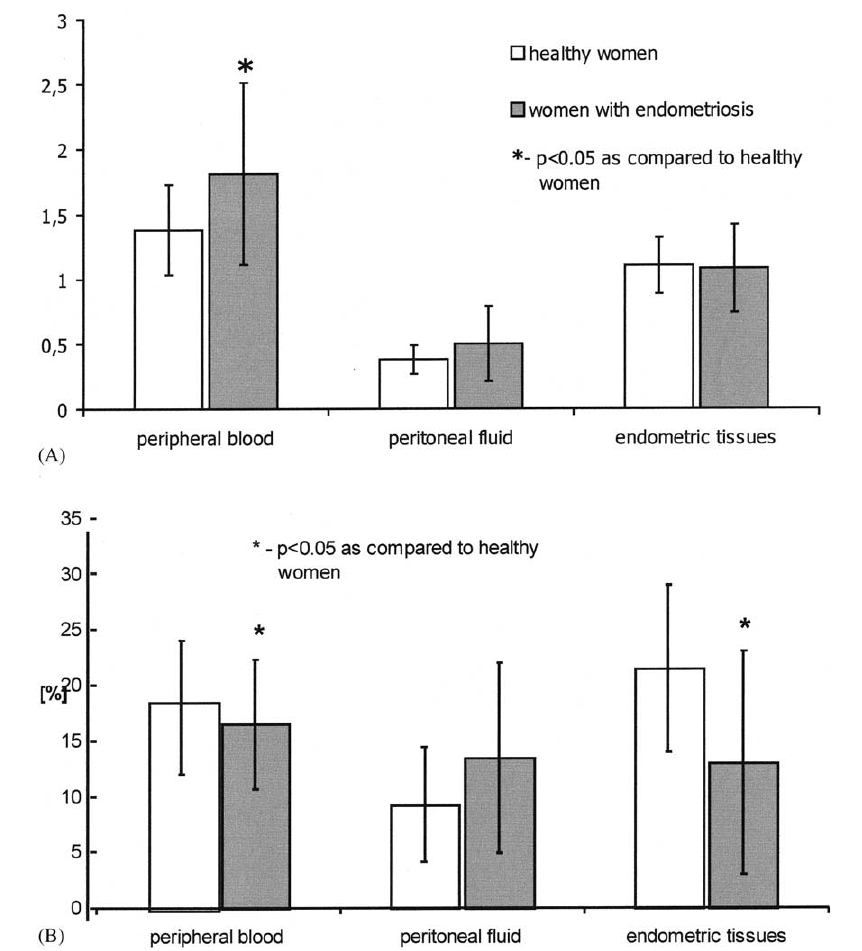
FIG. 3. Distribution of CD4:CD8 index (A) and NK cell percentages (B) in women with endometriosis (60) and in healthy volunteers (30). The number of performed investigations is presented in parentheses. Mean 9 / standard